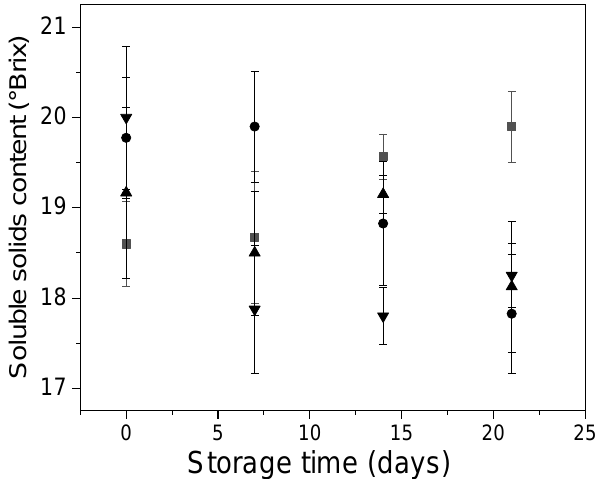
Figure 5. Behavior of the Andean blueberry soluble solids content during storage. Control ( ■ ), alginate (●), alginate/CNFs 0.1% ( ▲ ), alginate/CNFs 0.3% ( ▼ ). Concerning the pH and the titratable acidity (%), no relevant differences were detected among the uncoated and the differently coated samples neither at the initial time nor during the storage period (Figure 6).